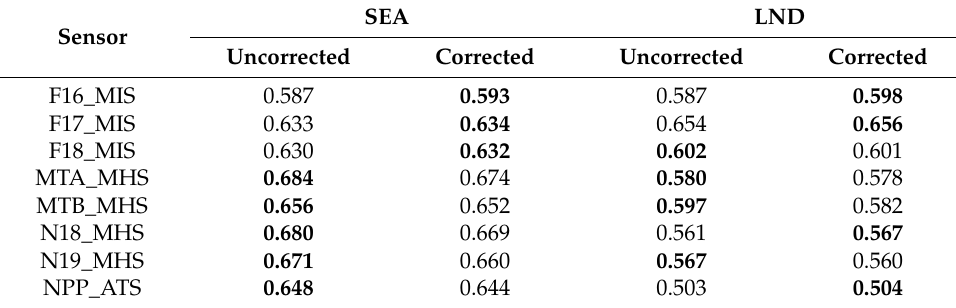
Table 4. The same as Table 2 except for CC.